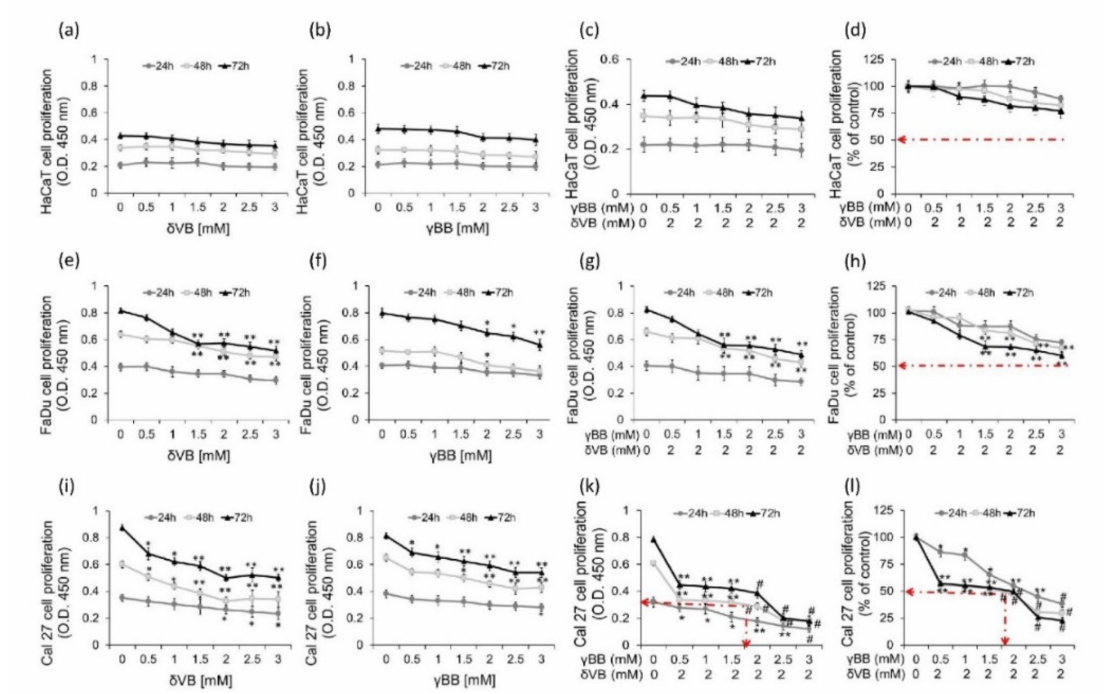
Figure 2. Inhibition of cell proliferation. Cell proliferation assays after exposure to di ff erent concentrations of δ VB or γ BB (up to 3 mM) or to δ VB (2 mM) plus serial concentrations of γ BB (0.5, 1, 1.5, 2, 2.5, 3 mM) cells for di ff erent times (24, 48 and 72 h) were performed in ( a – d ) HaCaT ( e – h ) FaDu and ( i – l ) Cal 27. The IC 50 in Cal 27 cells was determined at 48 h incubation with 2 mM δ VB plus 1.62 mM γ BB. Control cells were grown in medium containing the same volume of HBSS-10 mM Hepes. Cell proliferation inhibition was assessed using Cell Counting Kit-8 assay. Values represent the mean ± SD of four independent experiments. * p < 0.05 vs. Ctr, ** p < 0.01 vs. Ctr, # p < 0.001 vs.